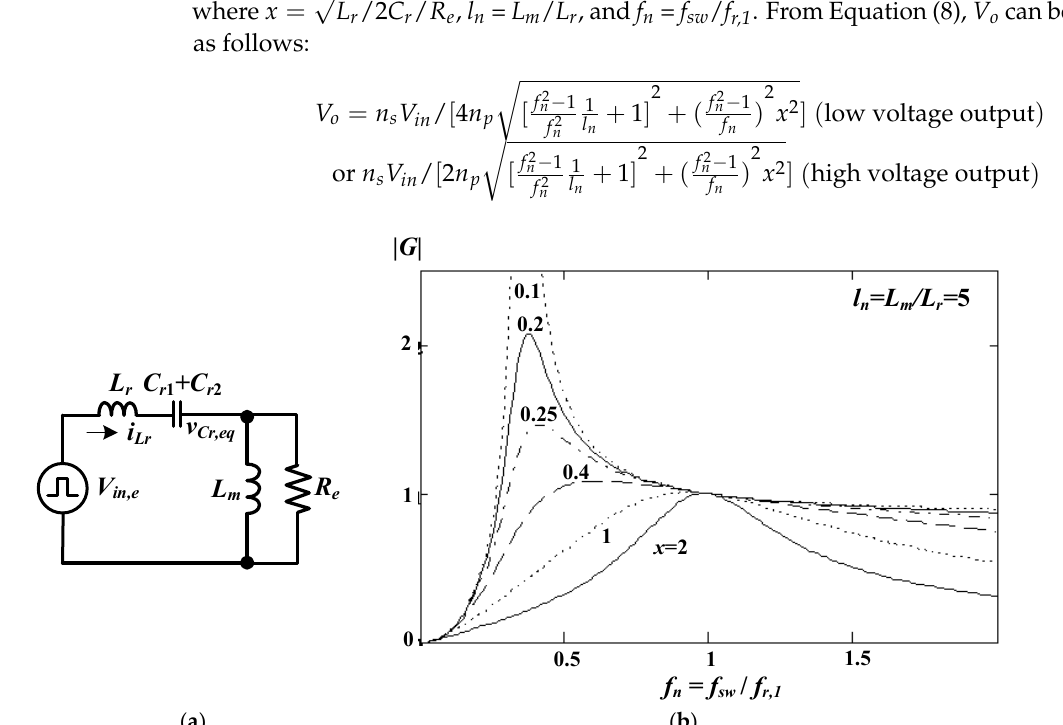
Figure 6. Resonant Tank of the proposed converter: ( a ) equivalent AC circuit and ( b ) AC voltage gain.